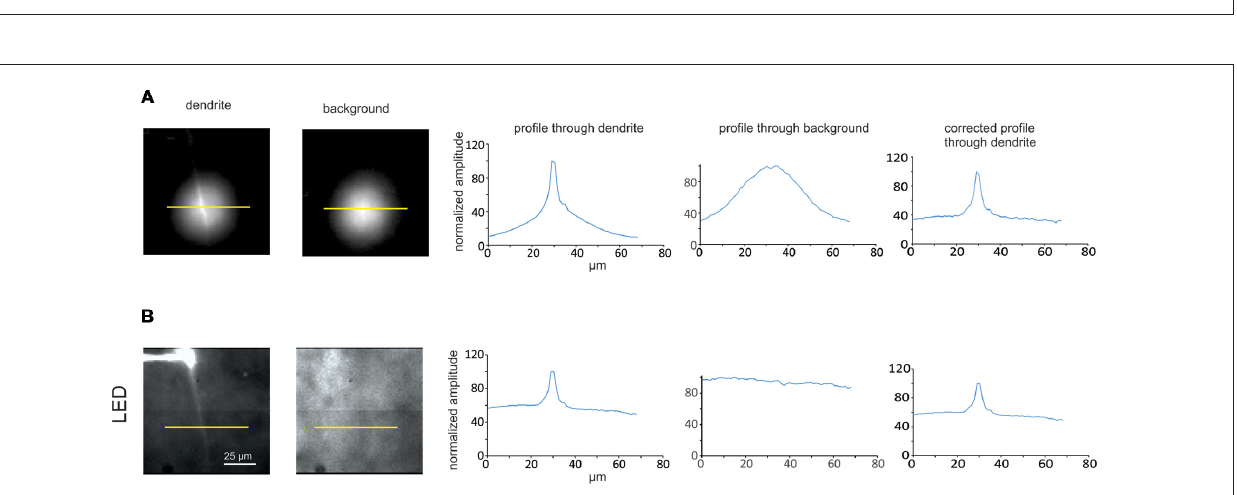
Frontiers in Cellular Neuroscience |